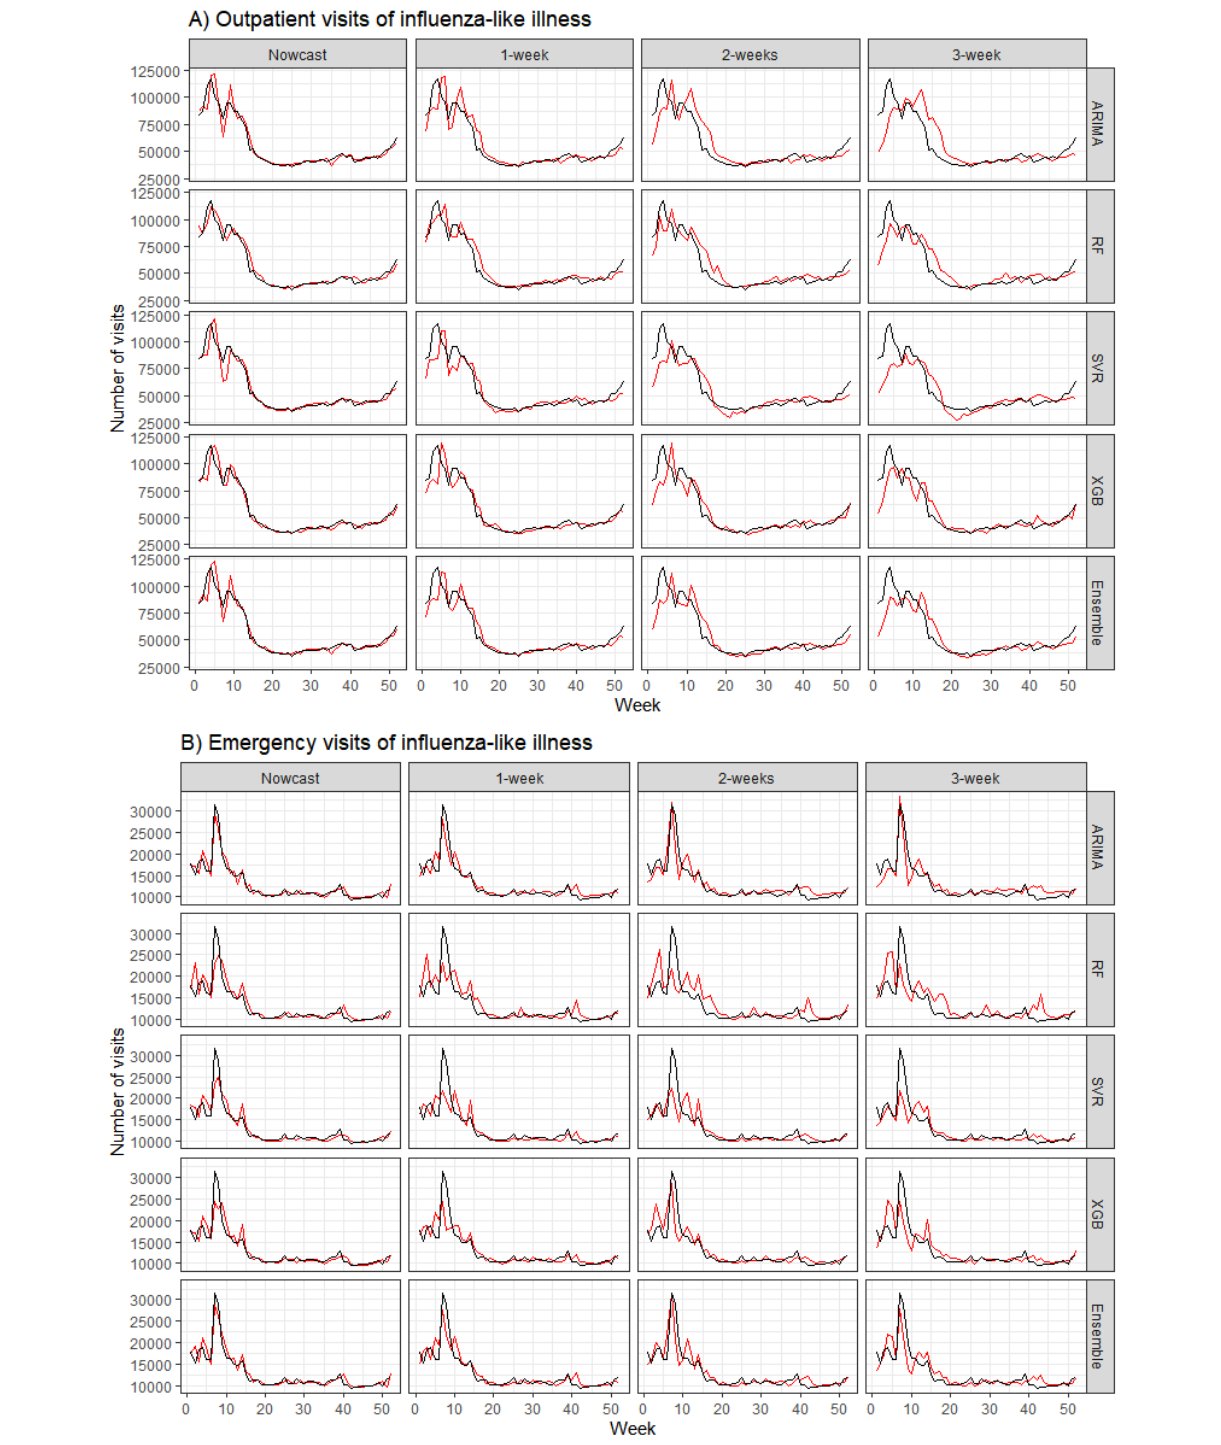
Figure 5. Forecasts of the 5 machine learning models (red) and the observed number (black) of influenza-like illness visits in (A) outpatient and (B) emergency departments, 2018. ARIMA: autoregressive integrated moving average; MAPE: mean absolute percentage error; RF: random forest; RMSE: root mean squared error; SVR: support vector regression; XGB: extreme gradient